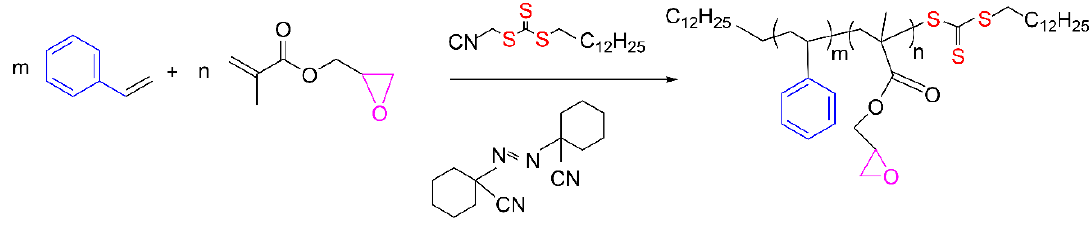
observed in Figure 3. The mole fraction of GMA in the copolymer was calculated as: F 2 = 5 A 3 /(5 A 3 + 3 A 2 ), where A 2 and A 3 are peak areas of phenyl and methyl protons, respectively. This method was used in this work due to the distinct NMR resonance of the GMA methyl group even at low GMA mole fractions in the copolymer [30].